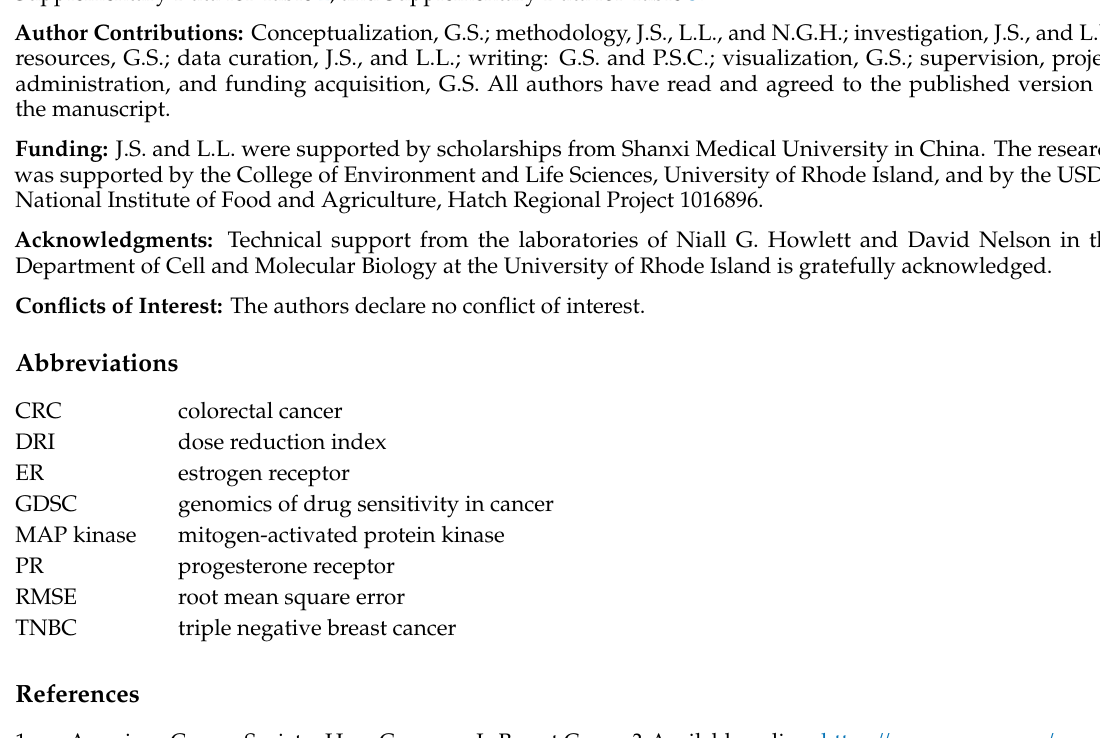
Figure S1: Full pictures of Western blot analyses of selected kinase inhibitors on MDA-MB-468 and MDA-MB-231 cell line signaling; Table S1: Densitometry analyses of the band density presented in Figure 6; Supplementary Data – Hill and Biphasic Analyses of the E ff ects of Dasatinib on MDA-MB-231; Supplementary Data for Table 1; Supplementary Data for Table 2; and Supplementary Data for Table